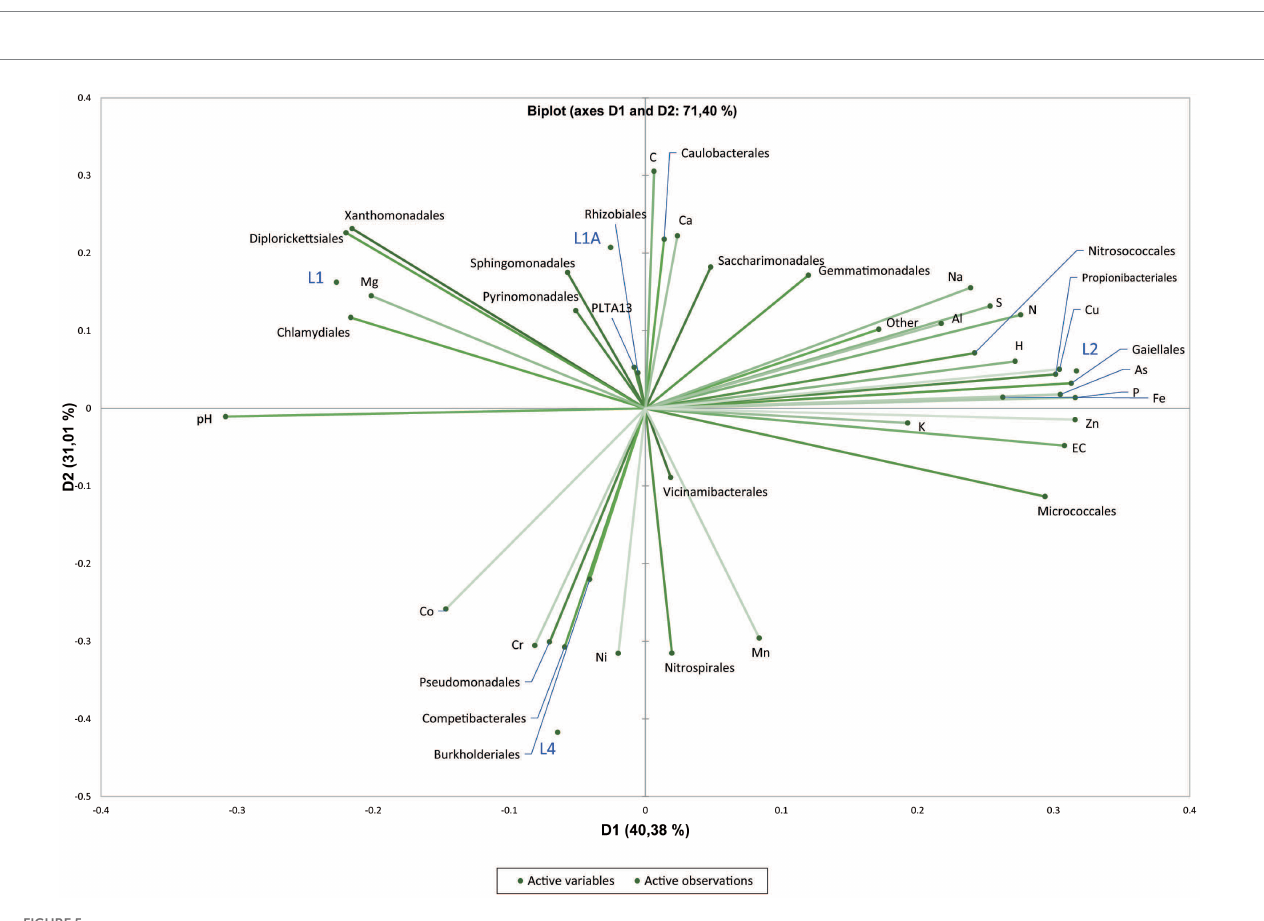
Diplorickettsiales and Xanthomonadales (L1), Sphingomondales (L1A), whereas L2 and L4 were highly different and spatially separated on the plot. L2 is defined by Propionibacteriales, Nitrosococcales, Cu, As, P, Fe, whereas L4 is defined by Competibacterales and Pseudomonadales, respectively Cr (Figure 5).